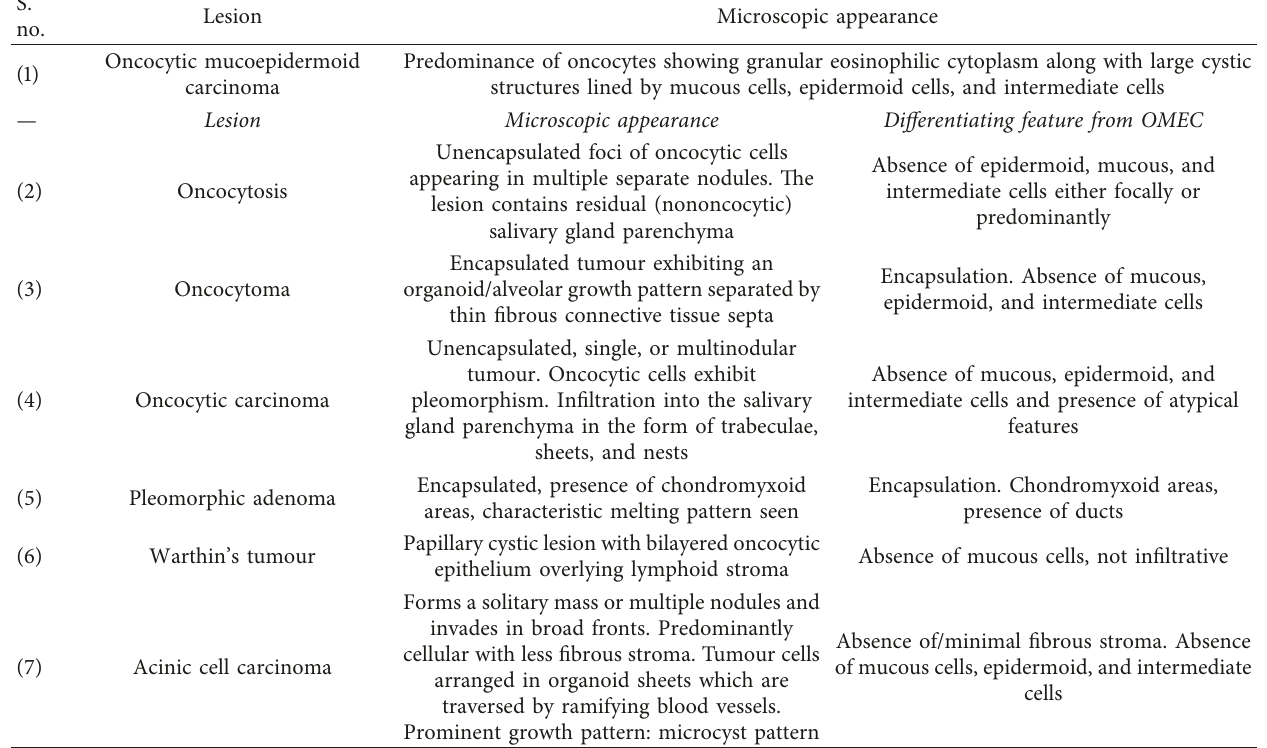
Table 1: Difference between OMEC and other oncocytic